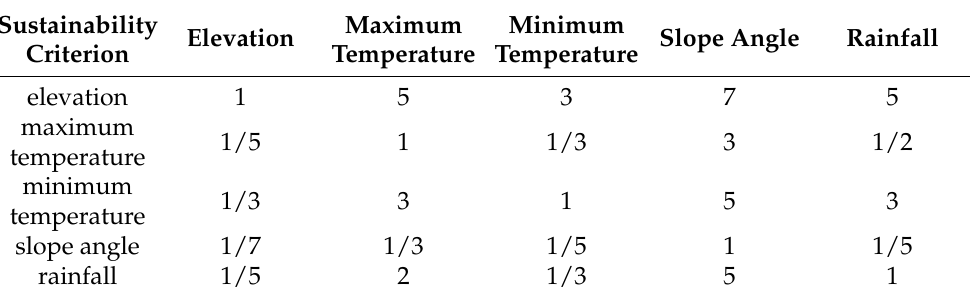
Table 2. A pairwise comparison matrix for the calculation of criteria weights for the citrus site selection (Table 4, Zabihi et al.